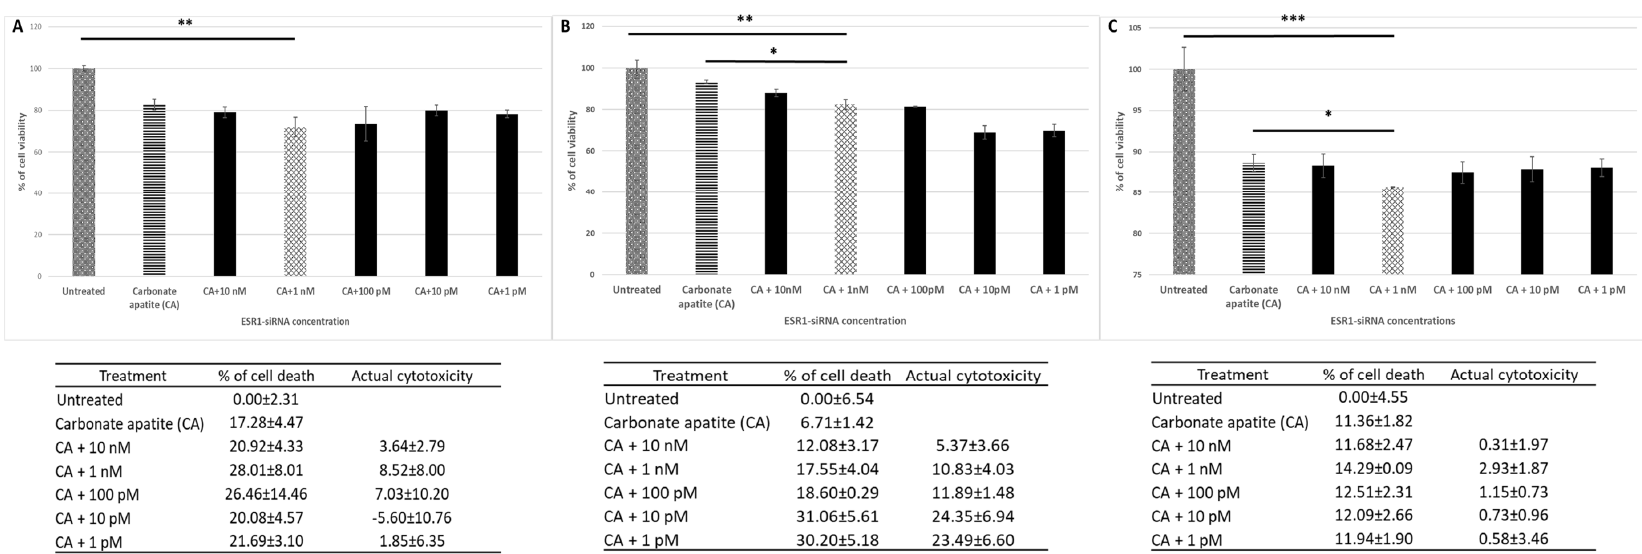
Figure 1. Cell viability and cytotoxicity assessments of MCF ‐ 7 cells ( A ), MDA ‐ MB ‐ 231 ( B ) and 4T1 ( C ) cells treated with CA ‐ ESR1 siRNA complexes for 48 h. Preparation of CA ‐ ESR1 siRNA complexes involved introduction of different concentrations of ESR1 siRNA (0 to 10 nM) and 3.5 mM of CaCl 2 to 1 mL of bicarbonate ‐ buffered DMEM (pH 7.4) medium. The mixture was allowed incubation at 37 °C for 30 min prior to addition of 10% FBS. The cells were incubated for the next 48 h with the prepared complexes. MTT assay was performed and absorbance reading was taken at 595 nm with 630 nm as references wavelength. Data was presented as mean ± SD of triplicates. * p < 0.05, ** p < 0.01 and *** p < 0.001.